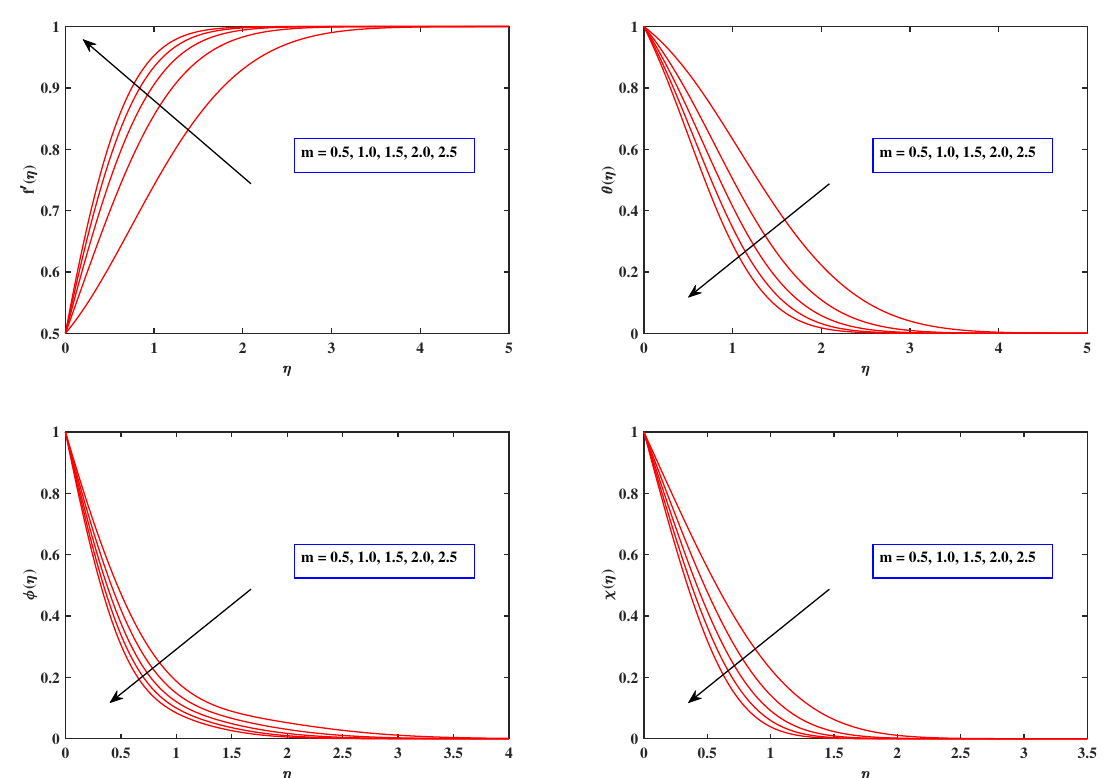
Figure 2. Fluctuation in profiles (velocity, temperature, concentration, and motile density) with m